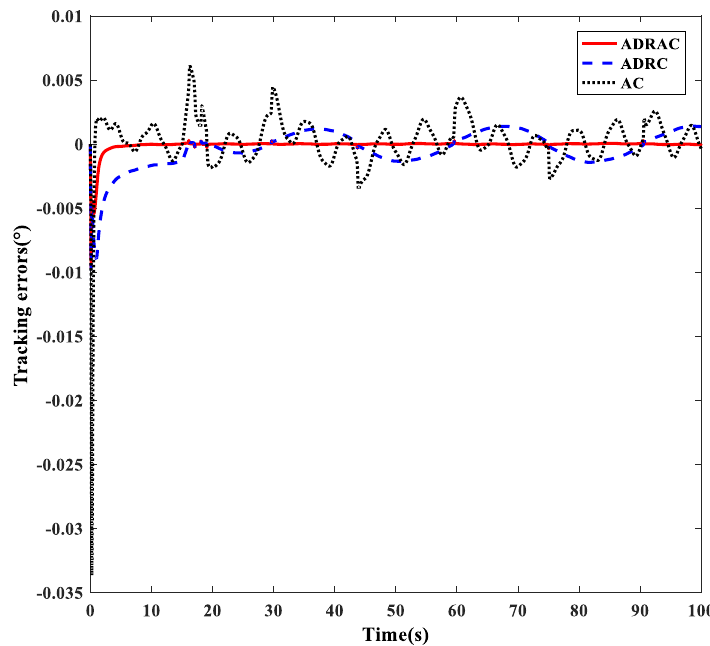
Figure 10. The tracking errors of the three controllers.